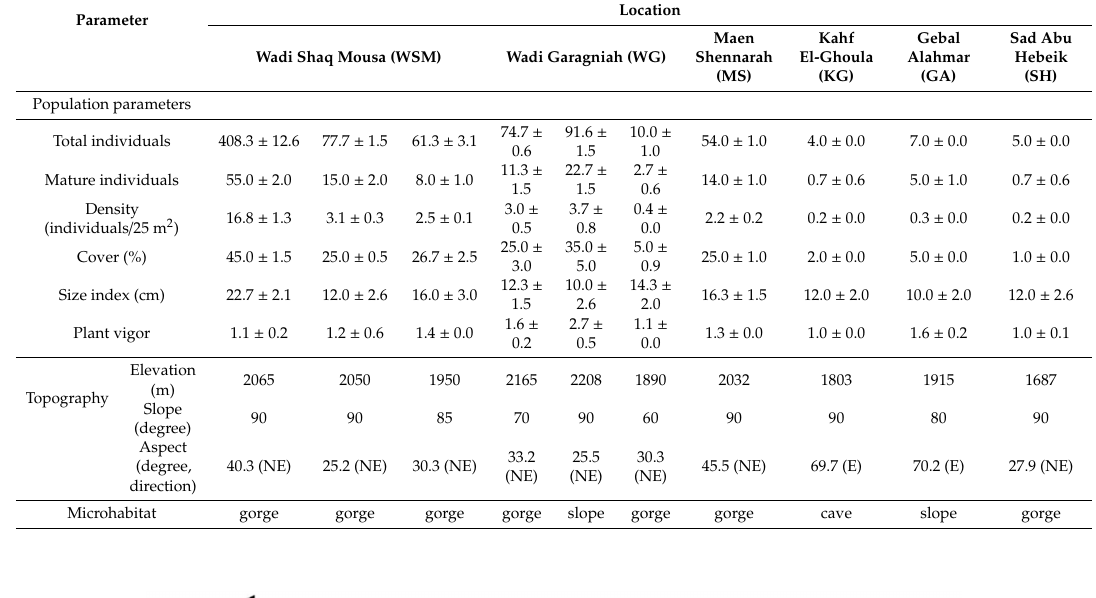
Table 1. The known current locations, population field parameters (mean ± SD), topography, and microhabitat of Primula boveana in Egypt.